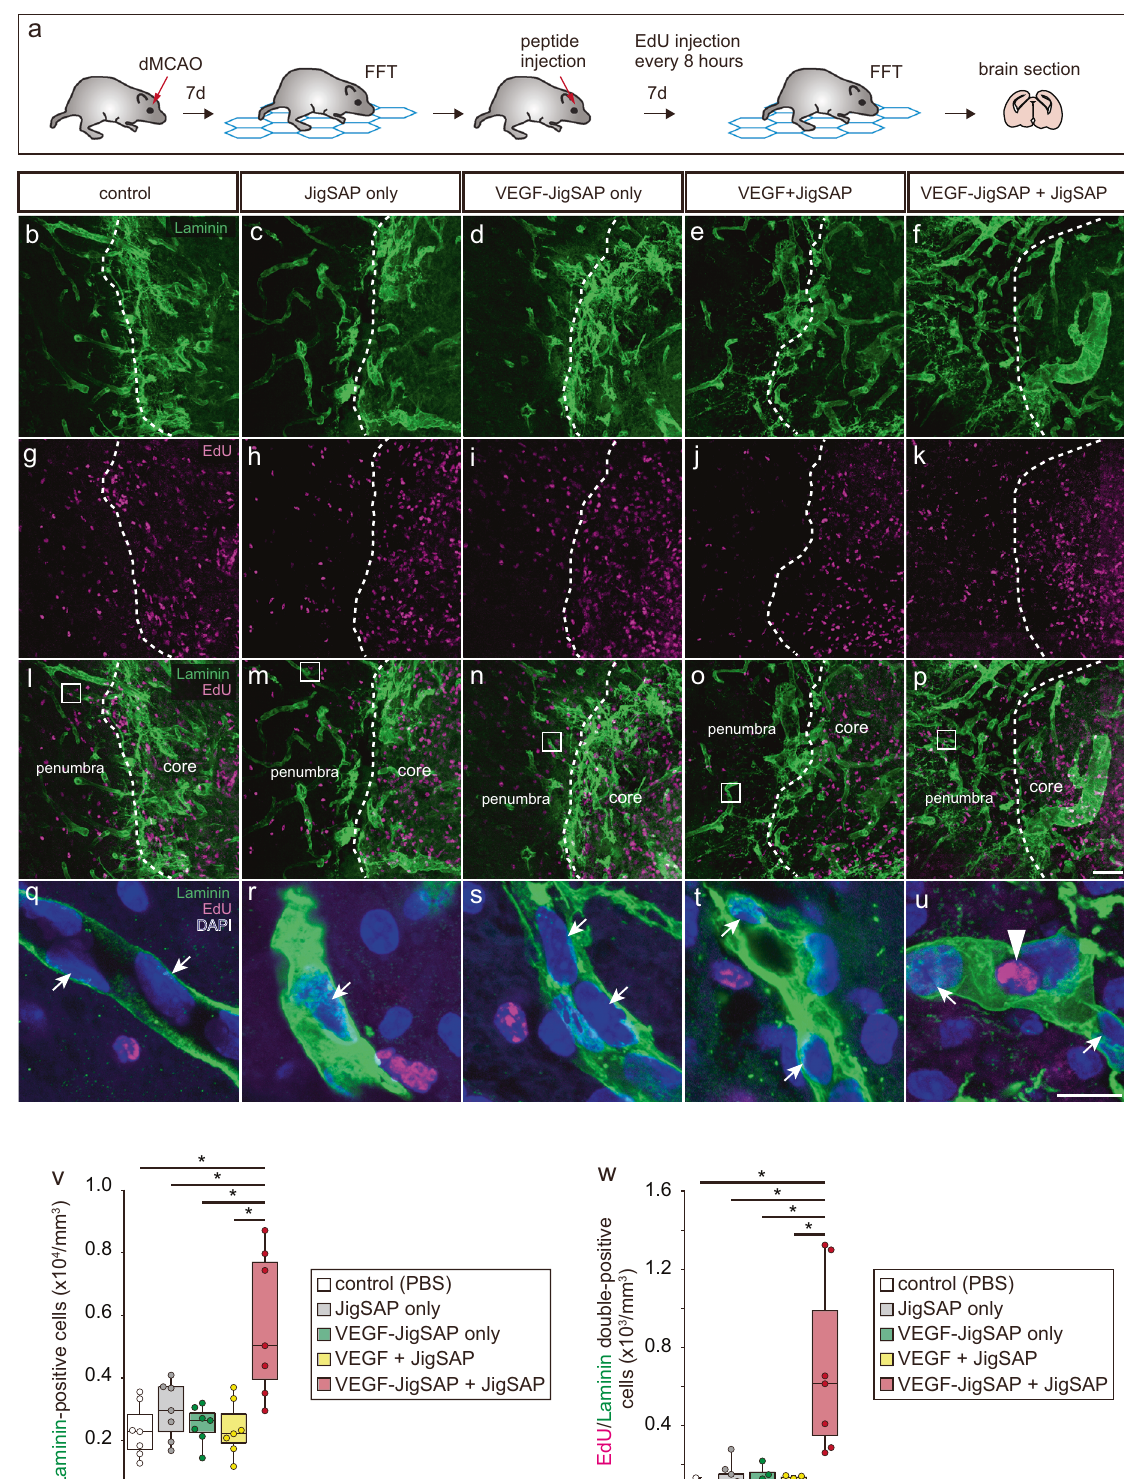
The behavioral recovery effect by VEGF-JigSAP + JigSAP was observed at 14 days after injection, but not at 21 days after injection because of the recovery of control mice (Supplemen- tary Fig. 28). These results indicated that a single injection of VEGF-JigSAP + JigSAP promoted recovery of the subacute- chronic phase of this mouse ischemic stroke model at the behavioral